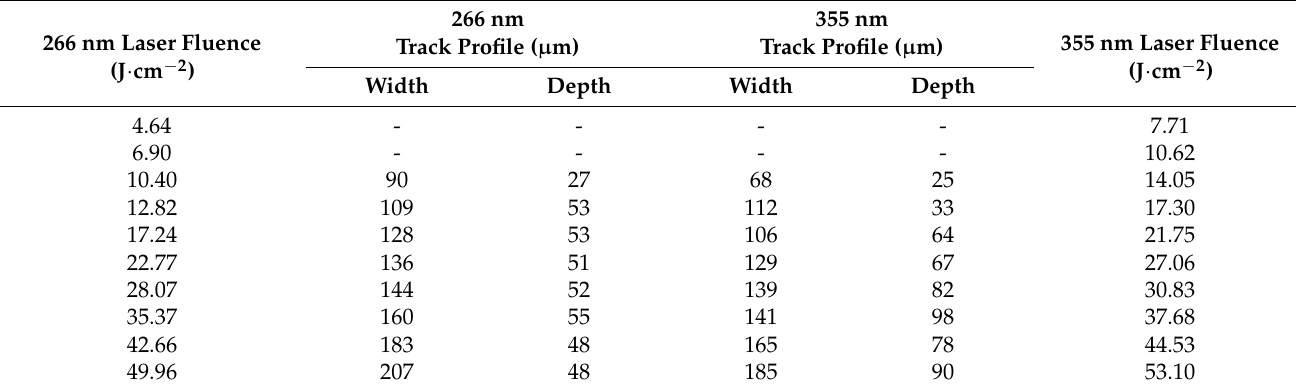
Table 1. Summary of the laser beam parameters and the size of the tracks after laser treatment of the PDMS surface. 266 nm Laser Fluence (J · cm − 2